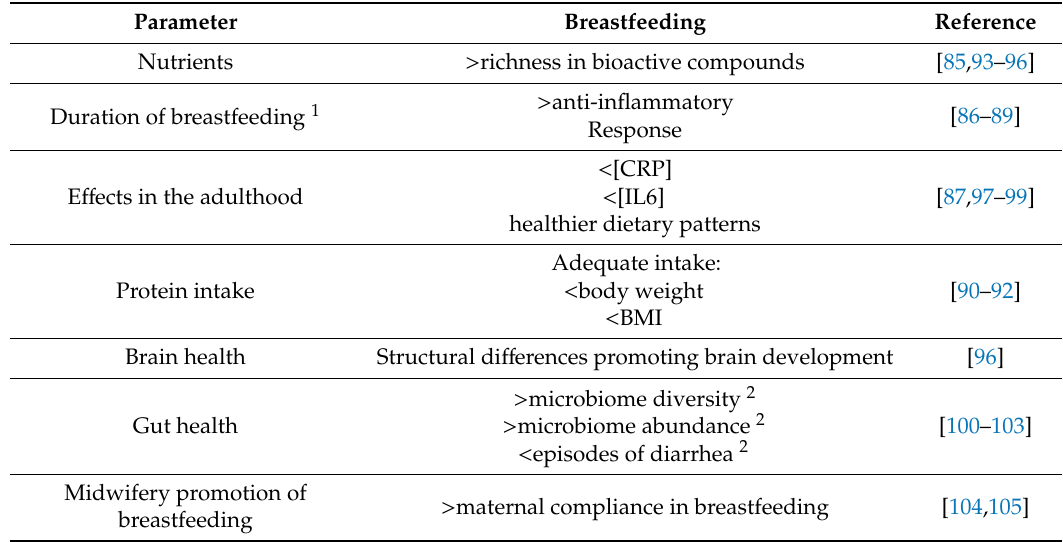
Table 1. Table summarizing the main findings of the positive impact of